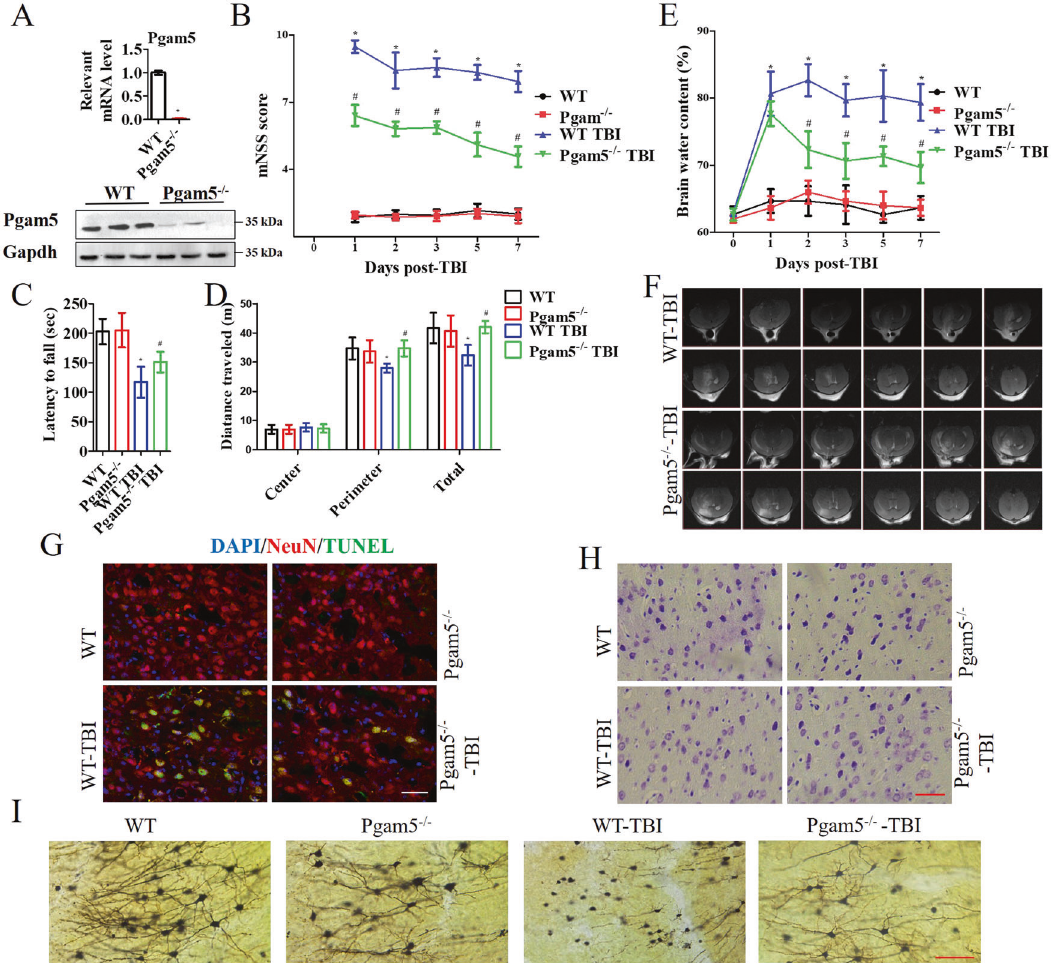
Fig. 1 Pgam5 de fi ciency improves neurological de fi cits, neuron damage, and neuronal neurites degeneration after TBI. A Western blot and RT-PCR results showed that Pgam5 expression was abolished in Pgam5 − / − mice. Neurological performances were assessed by ( B ) mNSS, ( C ) Rotarod test, and ( D ) open fi eld test, n = 8. E At 1, 2, 3, 5, and 7 days after TBI in WT and Pgam5 − / − mice, the brain water content was detected. F At 2 days after TBI, the T2-weighted MRI images showed histological impairments. G Cortical injuries to coronal sections were assessed using TUNEL staining 48 h post-TBI. Nuclei were stained with DAPI and neurons were stained with NeuN. H Nissl staining was performed to determine the morphological changes and damage of cortex neurons after TBI. I Representative pictures from cortical sections show prominent Golgi-Cox staining of degenerating neurites 2 days post-TBI. The images shown are representative of typical images from 6 mice in each group. E~I, n = 6. Data shown are means ± SEM, * p < 0.05 compared to the WT group and # p < 0.05 com p ared to WT TBI group by two-way ANOVA followed by Tukey ’ s post hoc multiple comparison